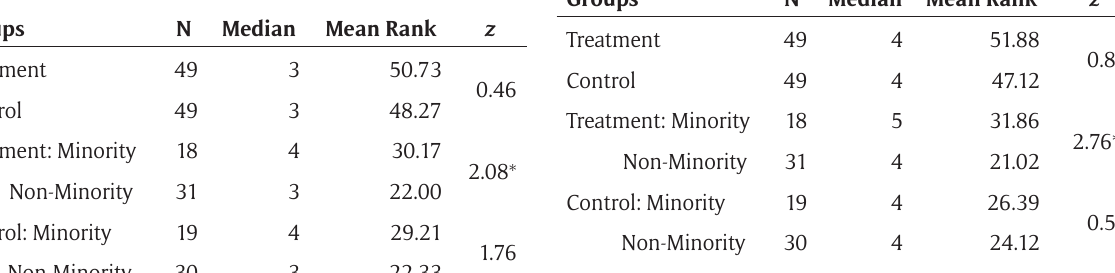
Table 3: Comparisons of groups on likelihood to